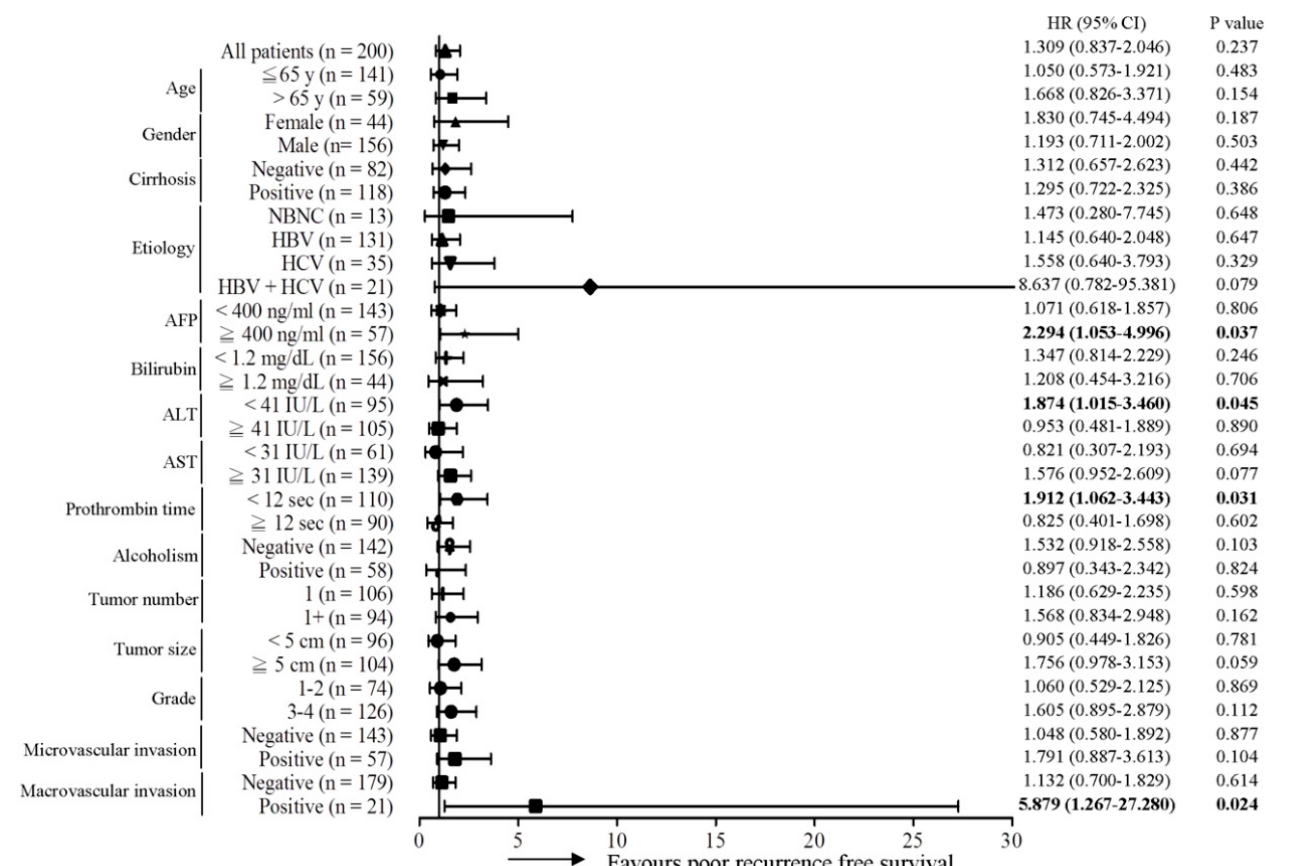
Figure 3. Forest plot subgroup analysis of HCC patients stratified by various clinical parameters to evaluate the association between MT-RNR1 G709A and intrahepatic recurrence-free survival. The Cox proportional hazard model was used to analyze MT-RNR1 G709A in relation to intrahepatic recurrence-free survival in subgroups. Horizontal lines represent 95% confidence intervals. NBNC: patients without HBV or HCV infection. HBV: patients with HBV infection. HCV: patients with HCV infection. The cut-off values for AFP, ALT, and AST were 400 ng/mL, 41 IU/L, and 31 IU/L.